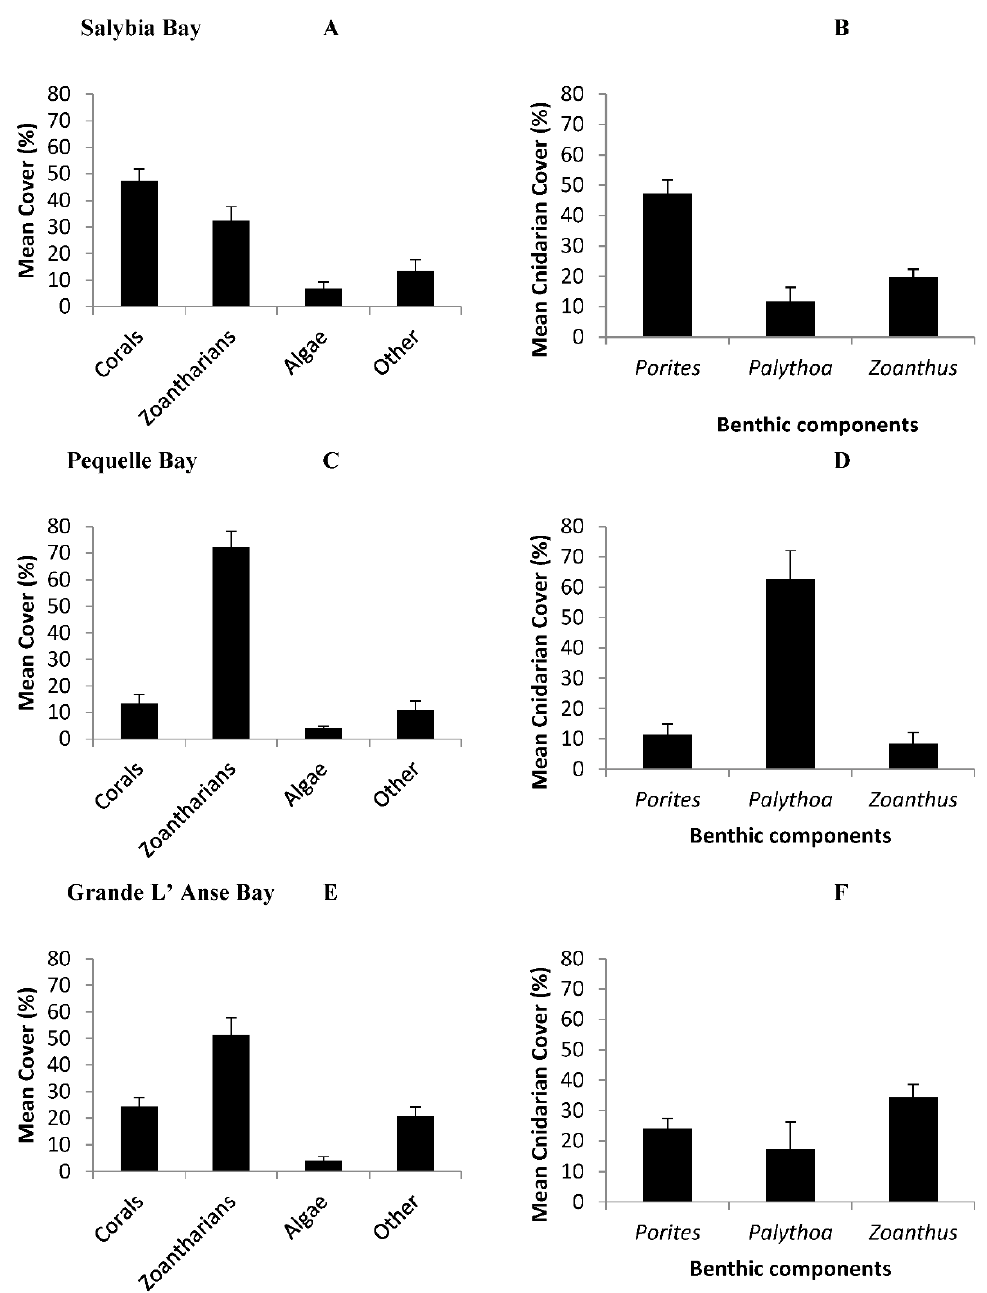
Figure 1. Mean benthic coverage (Mean% ± SD) at three sites in the lower intertidal zones illustrating reef-building “corals”, zoantharians, algae represent green algae, and “Other” includes all other invertebrates, such as sea urchins, sea cucumbers ( A , C , E ), and mean benthic cover (Mean% ± SD) of Porites , Palythoa , and Zoanthus spp. ( B , D , E ); ( A , B ) Salybia Bay ( C , D ) Pequelle Bay ( E,F ) Grande L’Anse Bay.